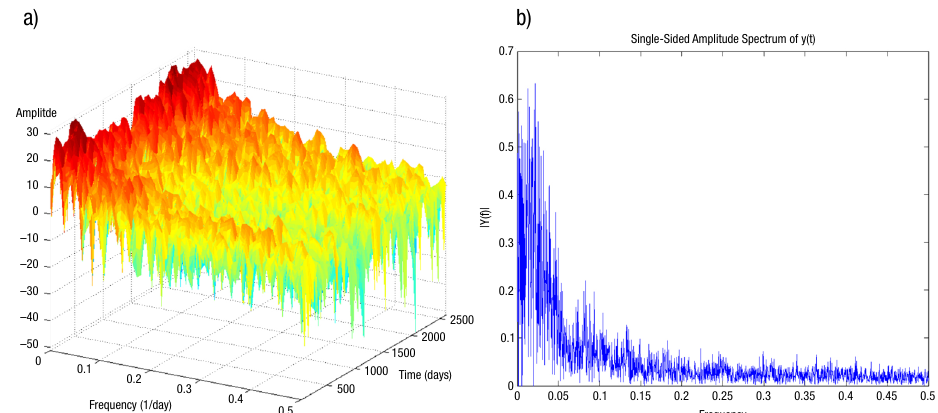
Fig. 4. The Boeing Company (BA) – 1- day period time series spectrogram (a), spectrum (b), source: own